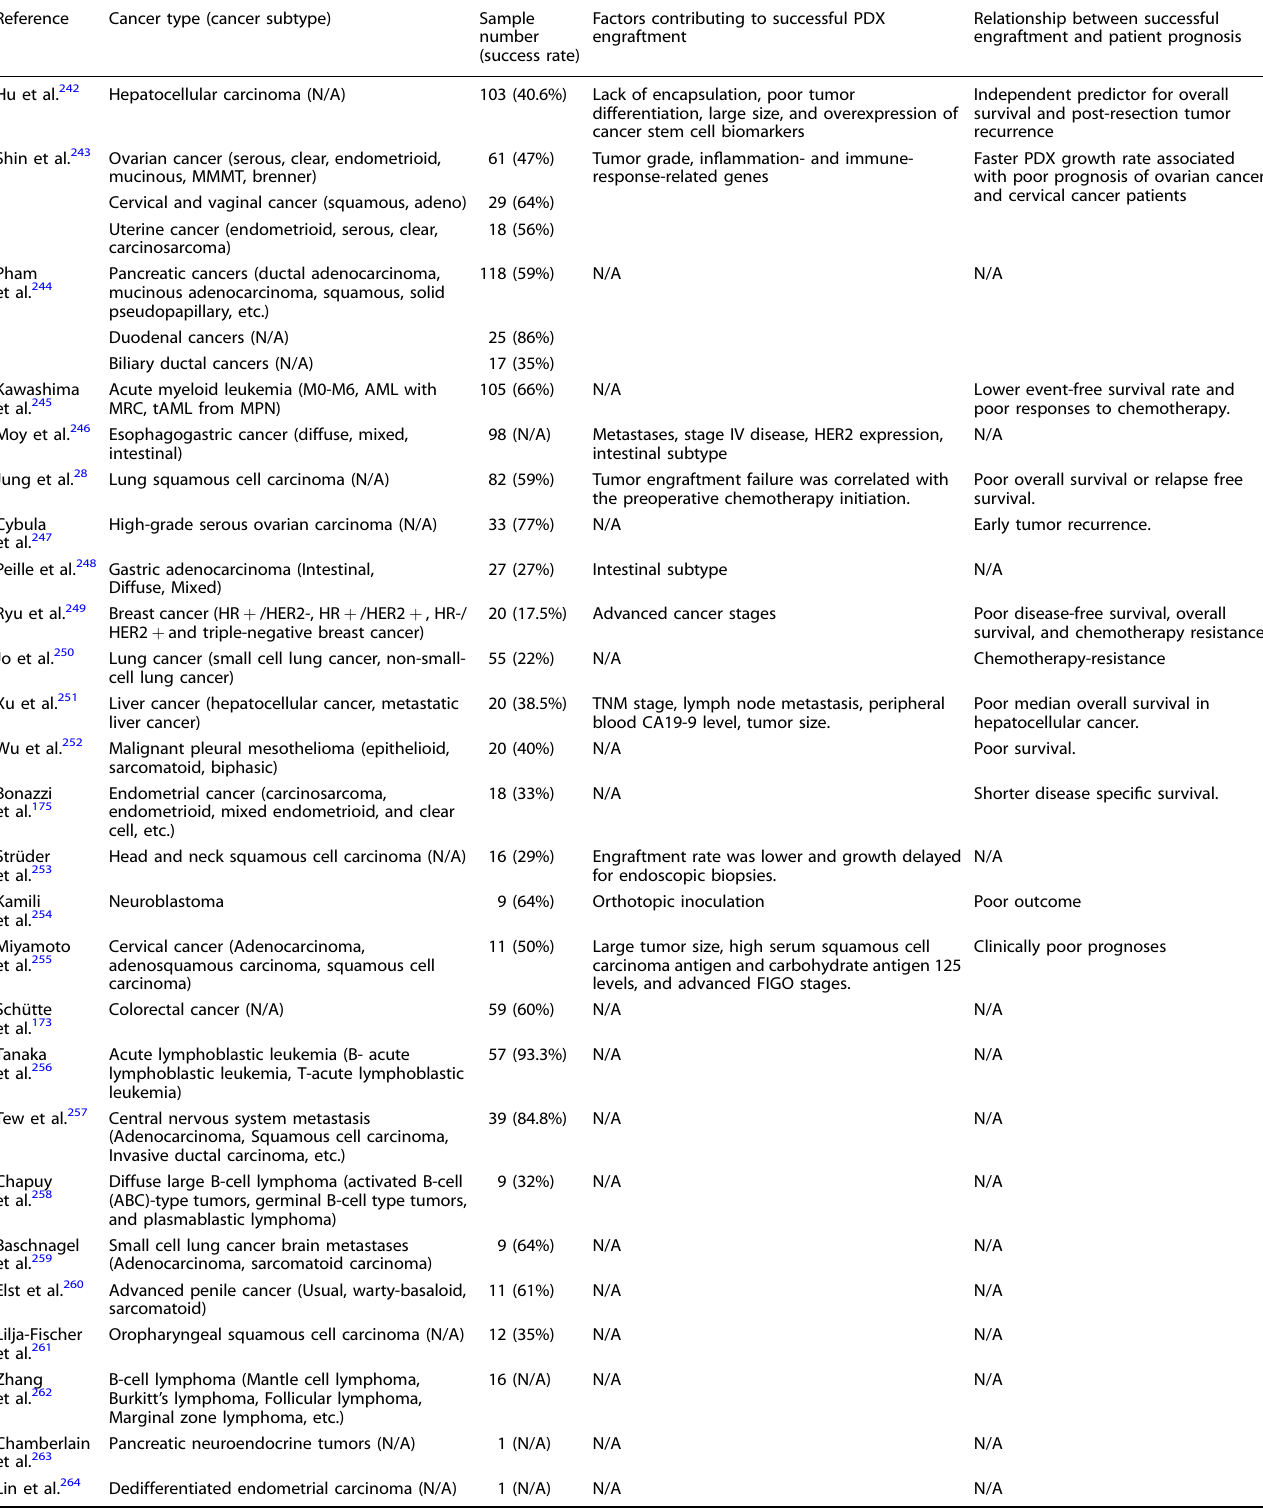
Table 1. PDX models and biobanks of different cancer